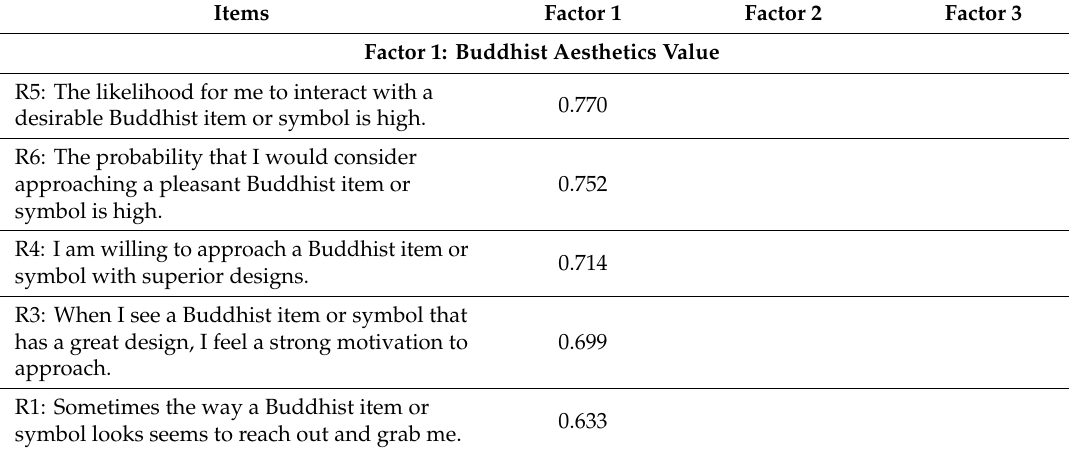
Table 3. Varimax rotation method for the Buddhist aesthetics scale in three